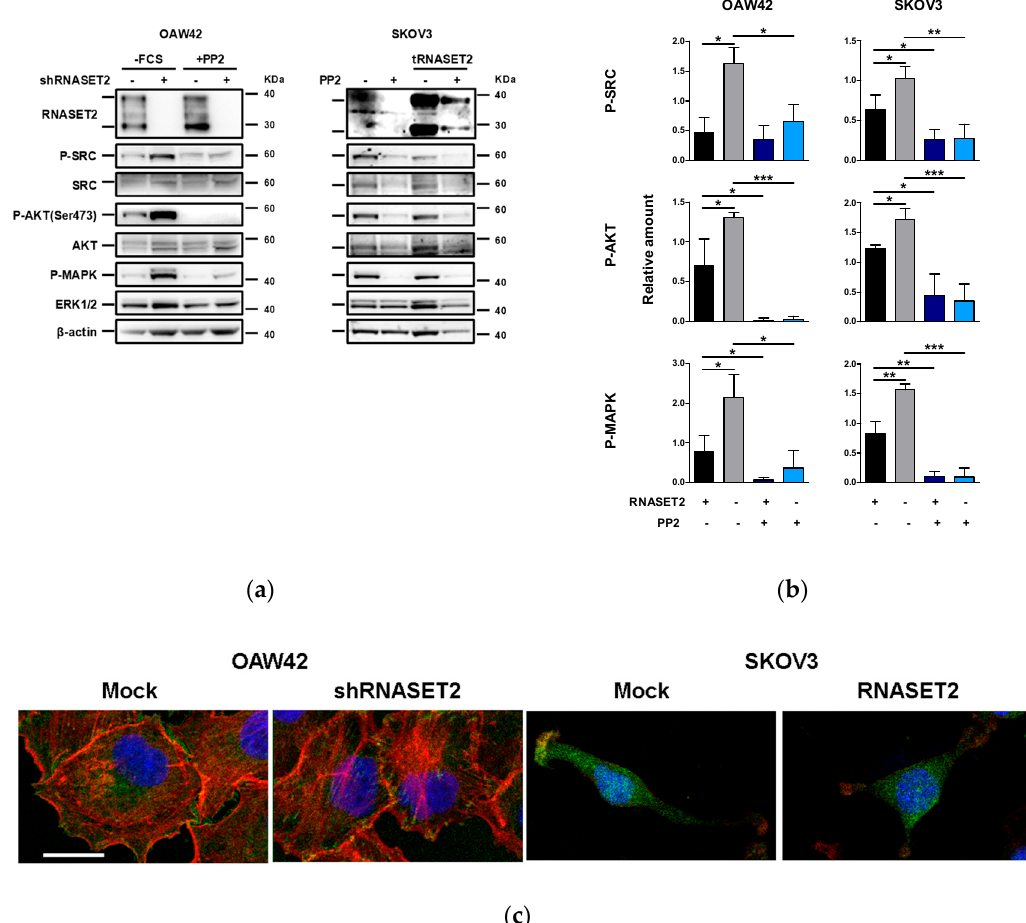
Figure 4. ‘RNASET2 phenotype’ negatively modulates src activation. ( a ) Western blotting on lysates from EOC cells untreated or treated with PP2 (20 µ M) and then left to adhere on fibronectin- coated (5 µ g/mL, for OAW42 cells) or on collagen type I- coated (5 µ g/mL, for SKOV3 cells) wells for 30 min. A representative experiment with each cell line (OAW42 or SKOV3) of three performed is shown. ( b ) Quantitative evaluation of P-SRC, P-AKT and P-MAPK analyzed in the Western blotting (WB) of three different experiments. The graph reports the ratio between the target protein and β -actin. Asterisks indicate statistically significant values by Student’s t -test (* p < 0.05; ** p < 0.01; *** p < 0.001). Immunoblottings were performed with Abs against the proteins reported on the left. β -actin was used as control for gel loading. Dark and light blue boxes highlight cell treated with PP2. ( c ) Confocal IF with antiphosphorylated paxillin (green) and phalloidin (red) performed on transfected EOC cells after adhesion to fibronectin (OAW42) or collagen I (SKOV3). Nuclei were stained with Dapi. Bar, 20 µ m. Larger captured images are reported in Figure S5.